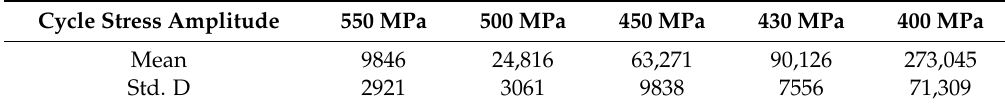
Table 4. Mean and standard deviations of fatigue life of the first group (tempering temperature 600 ◦ C).